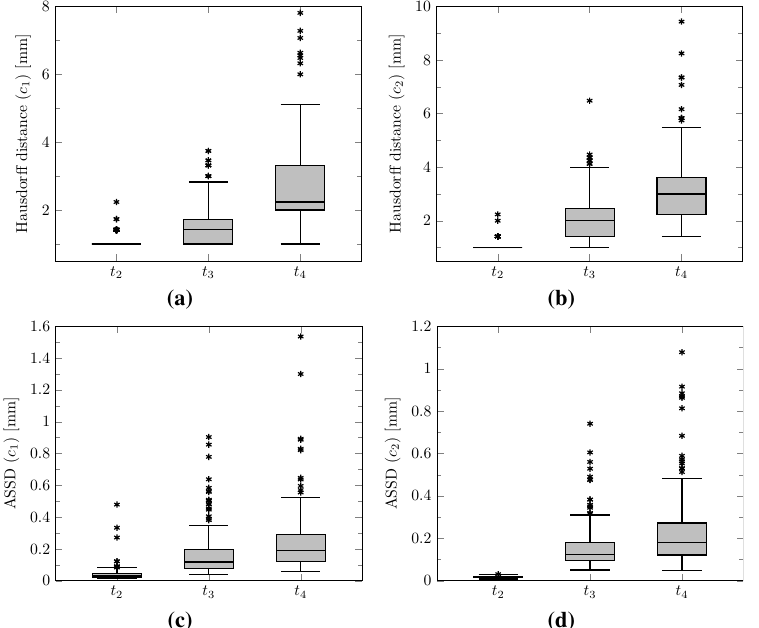
Figure 8. Boxplots of the Hausdorff distance and average symmetric surface distance (ASSD) dis- tributions computed between the true and estimated imaging contours over the whole test set for times t 2 = ∆ t 1 + ∆ t 2 ∈ [ 180, 360 ] d (see Table 1), t 3 = t 2 + 90d, and t 4 = t 2 + 180d. ( a , b ) Hausdorff distances computed between the true and estimated imaging contours obtained for threshold values of c 1 = 0.80 and c 2 = 0.16, respectively. ( c , d ) ASSD values computed between the true and estimated imaging contours obtained for threshold values of c 1 = 0.80 and c 2 = 0.16, respectively. Horizontal line: median, box: interquartile range, whiskers: ± 1.5 interquartile range, asterisks: